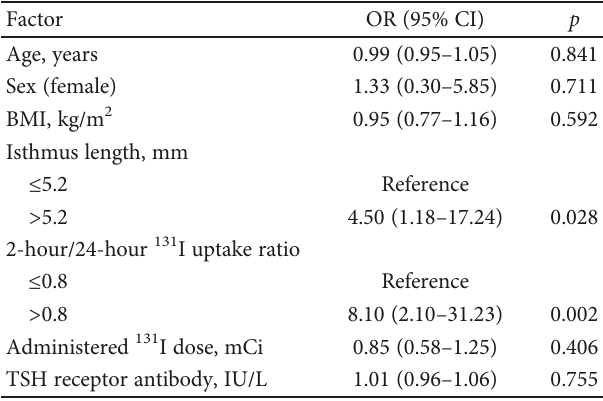
Table 3: Multivariate logistic regression analysis of factors associated with persistent hyperthyroid status after radioactive iodine